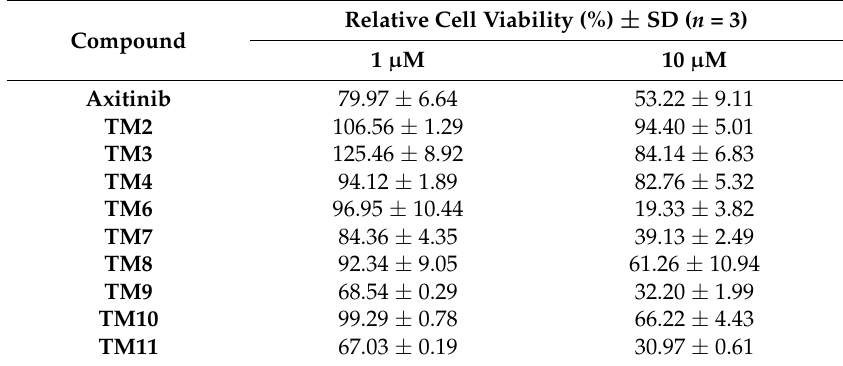
Table 2. In vitro anti-proliferative activity assay results of target compounds in HUVEC.